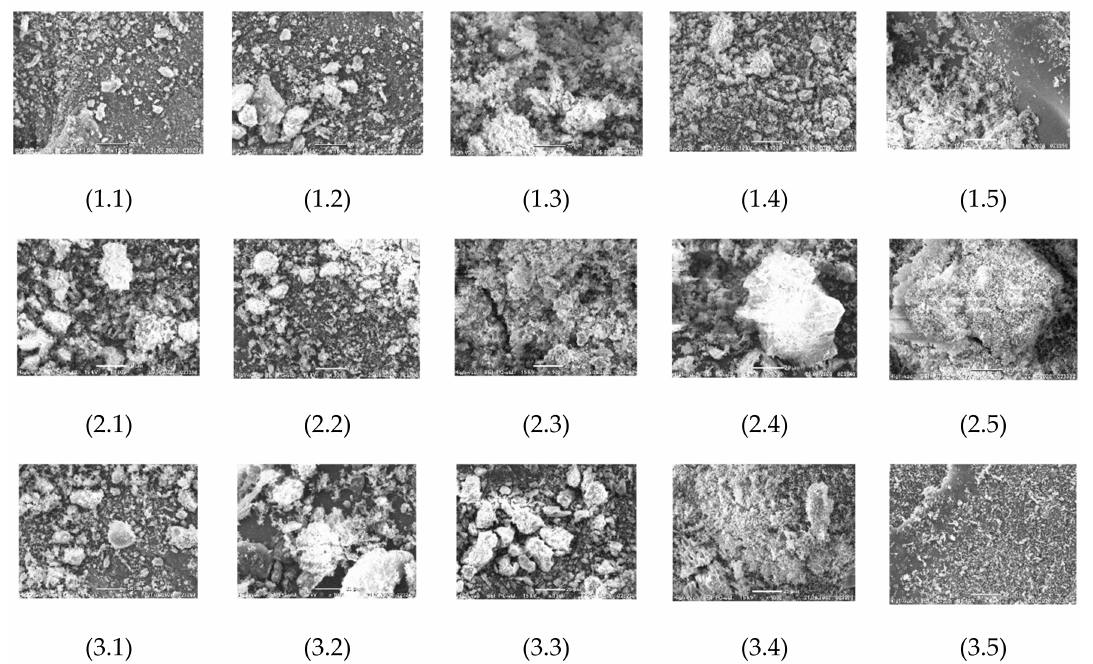
Figure 8. Typical images (of scanning microscopy) of pyrolysis products after pyrolysis of T grade coal particles, wood, and a set of pyrolysis products particles of fuel mixtures based on them in different component ratios: 1-Ash after pyrolysis at a temperature of 400 ◦ C: 1.1 Coal_100%; 1.2. Coal_90%/Wood_10%; 1.3. Coal_75%/Wood_25%; 1.4. Coal_50%/Wood_50%, 1.5. Wood_100%; 2-Ash after pyrolysis at a temperature of 600 ◦ C: 2.1 Coal_100%; 2.2. Coal_90%/Wood_10%; 2.3. Coal_75%/Wood_25%; 2.4. Coal_50%/Wood_50%, 2.5. Wood_100%; 3-Ash after pyrolysis at a temperature of 800 ◦ C: 3.1 Coal_100%; 3.2. Coal_90%/Wood_10%; 3.3. Coal_75%/Wood_25%; 3.4. Coal_50%/Wood_50%, 3.5. Wood_100%.